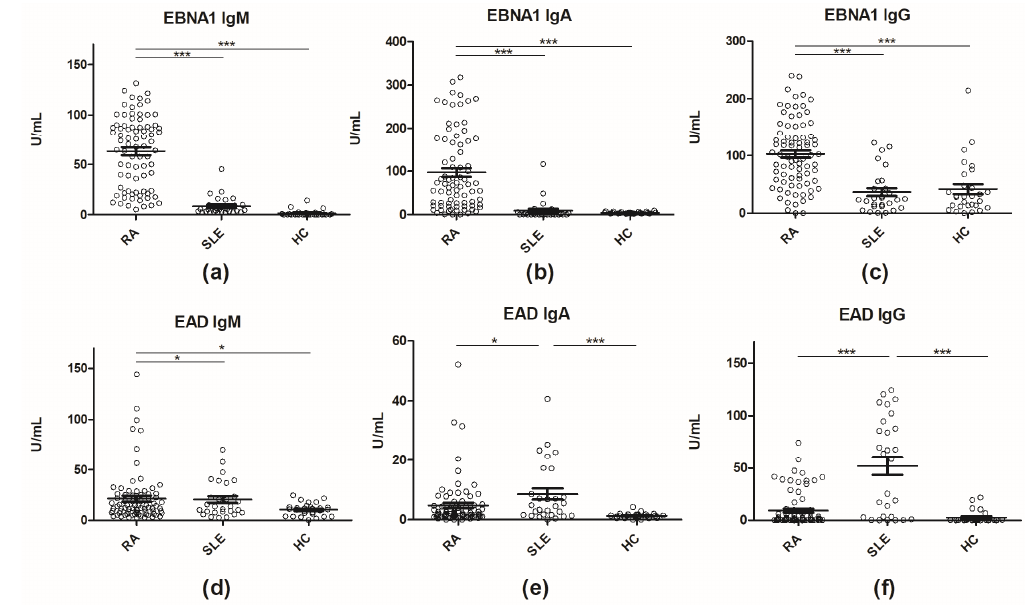
Figure 1. Reactivity of rheumatoid arthritis (RA) ( n = 77), systemic lupus erythematosus (SLE) ( n = 27 and healthy control (HC) sera ( n = 29) to early antigen di ff use (EAD) and Epstein-Barr Virus nuclear antigen (EBNA) 1 (IgM, IgA and IgG reactivity) analyzed by enzyme-linked immunosorbent assay.